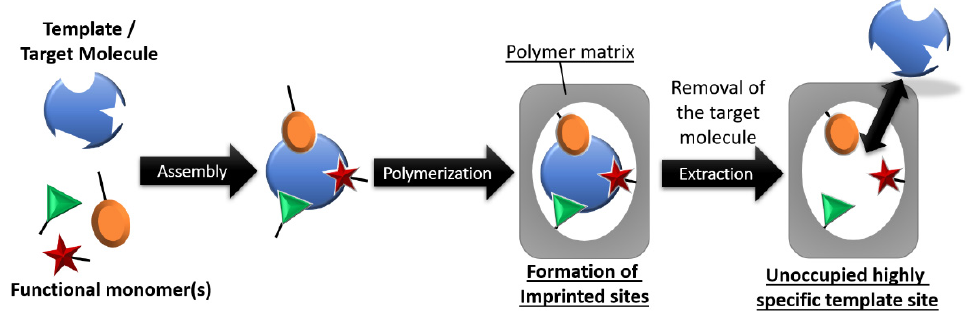
Figure 2. Schematic representation of the synthesis and the extraction of a MIP.